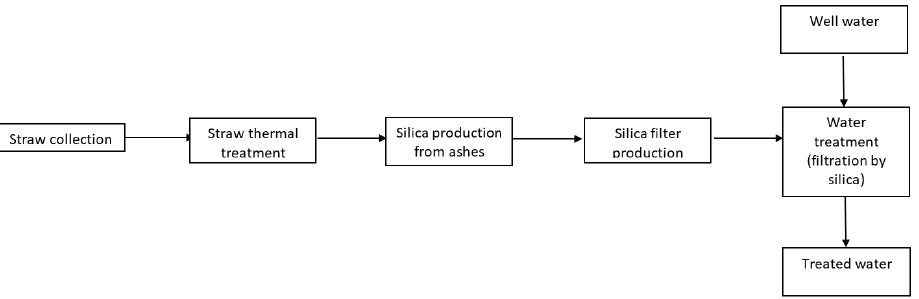
Figure 1. Scheme of innovative process developed within the EU-funded project LIFE-LIBERNI- TRATE.